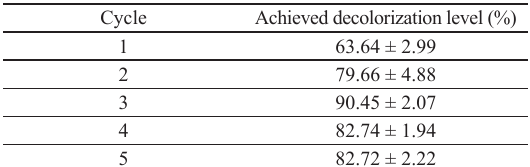
Table 4. Results of decolorization levels after 5 cycles of photocatalysis of 65/1 heat-treated ZnO composition at 1000 °C/2